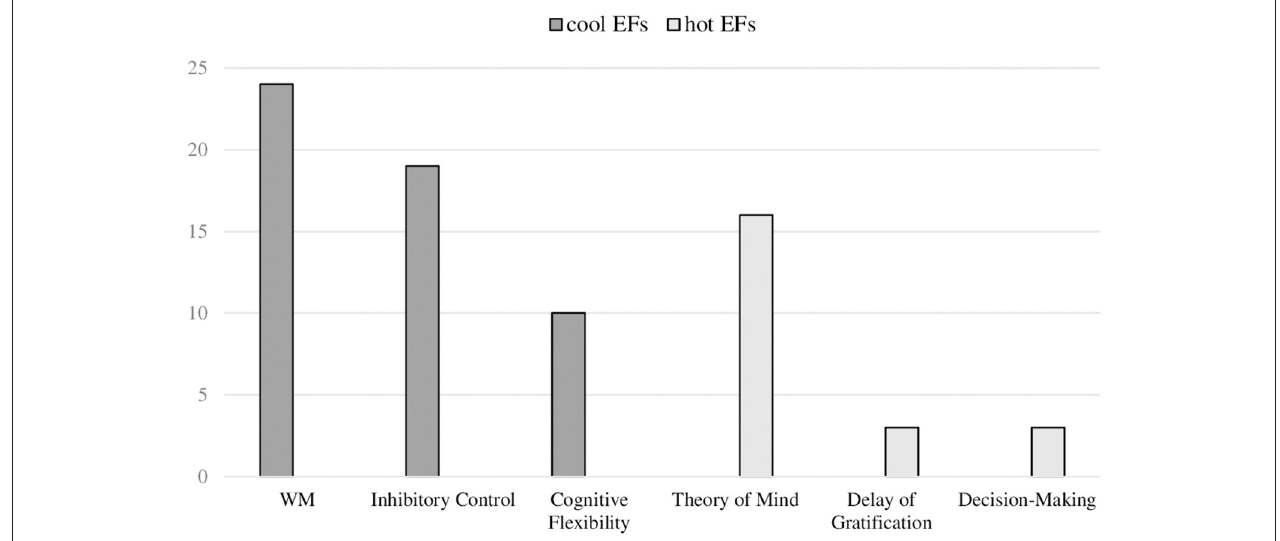
FIGURE 3 | Number of studies included in systematic review, based on cool and hot executive functions analyzed. Working Memory ( n = 24): (Bock et al., 2015; Kennedy et al., 2015; Kharitonova et al., 2015; Lee Swanson et al., 2015; Rajan and Bell, 2015; Roberts et al., 2015; Bellaj et al., 2016; Lagattuta et al., 2016,